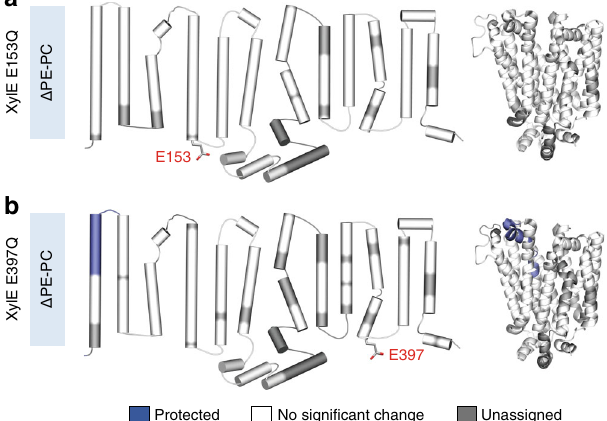
Fig. 6 Disruption of conserved charge networks abolishes or decreases lipid-induced conformational shift. Δ HDX of XylE in PE:PG:CL nanodiscs (native- like) minus PC:PG:CL (control) nanodiscs mapped on the PDB structure and the topological representation of XylE for ( a ) XylE E153Q and ( b ) XylE E397Q. All measurements were performed in